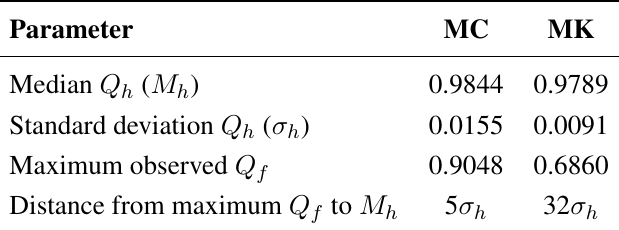
and a bigger distance between h